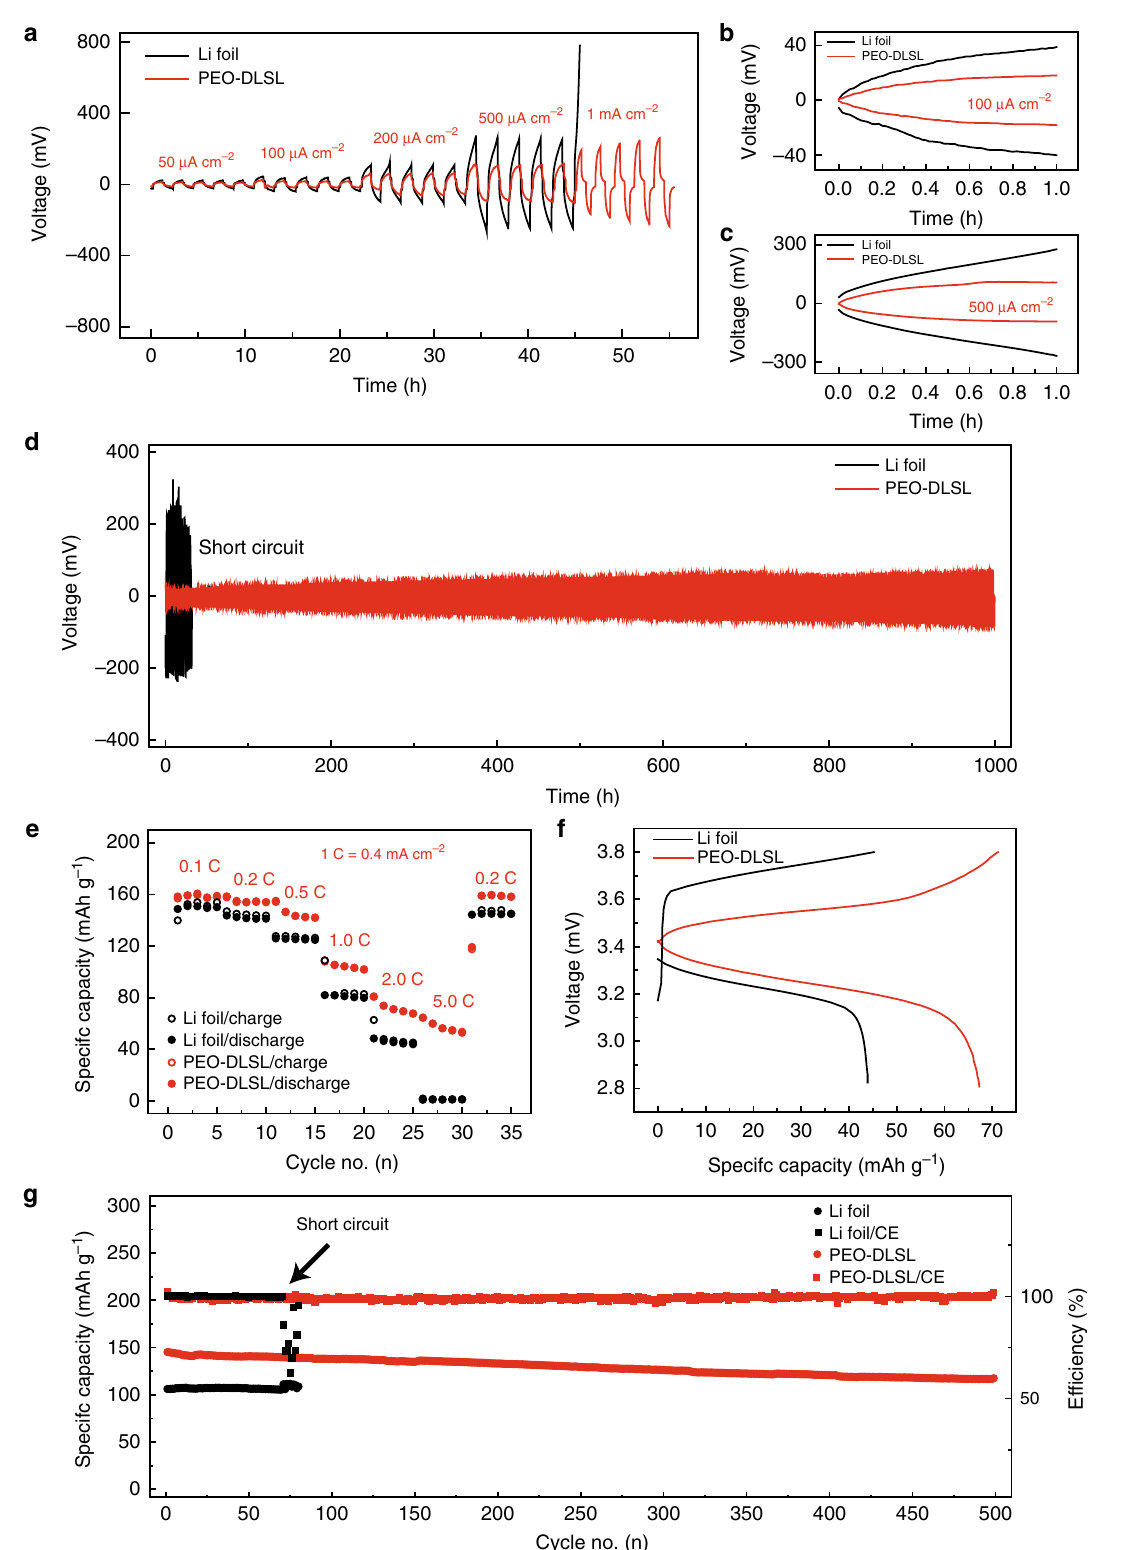
Fig. 5 Electrochemical performance comparison of the cells using PEO-DLSL and planar Li-foil anode, respectively. a Voltage pro fi les of symmetric cells using different anodes at different current densities. b , c Detailed voltage pro fi les at the current density of 0.1 and 0.5 mA cm − 2 , respectively. d Comparison of the long-term cycling stability of the symmetric cells with PEO-DLSL and Li-foil anodes at a current density of 0.5 mA cm − 2 . e Rate capability comparison of Li-LFP full batteries with PEO-DLSL and Li-foil anode. f GDC curves of PEO-DLSL/LFP and Li-foil/LFP full cells at 2 C current density. g Long-term cycling performance of batteries at a current density of 0.5 C. All cells were operated at 60